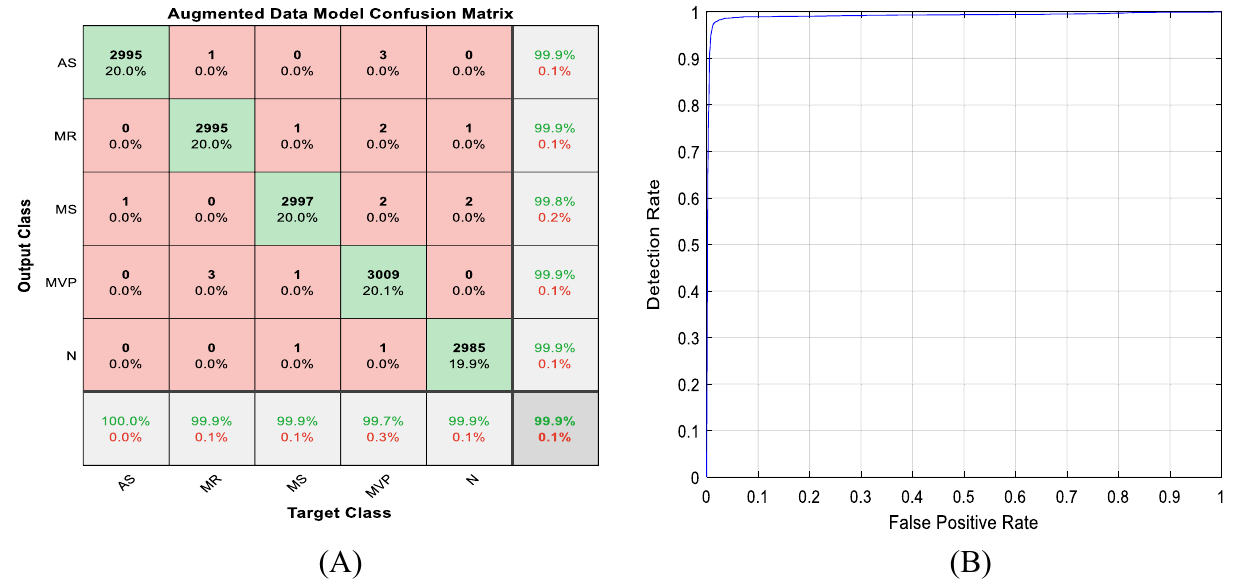
Figure 13. ( A ) Augmented data model confusion matrix. ( B ) Receiver operating characteristic (ROC) curve.